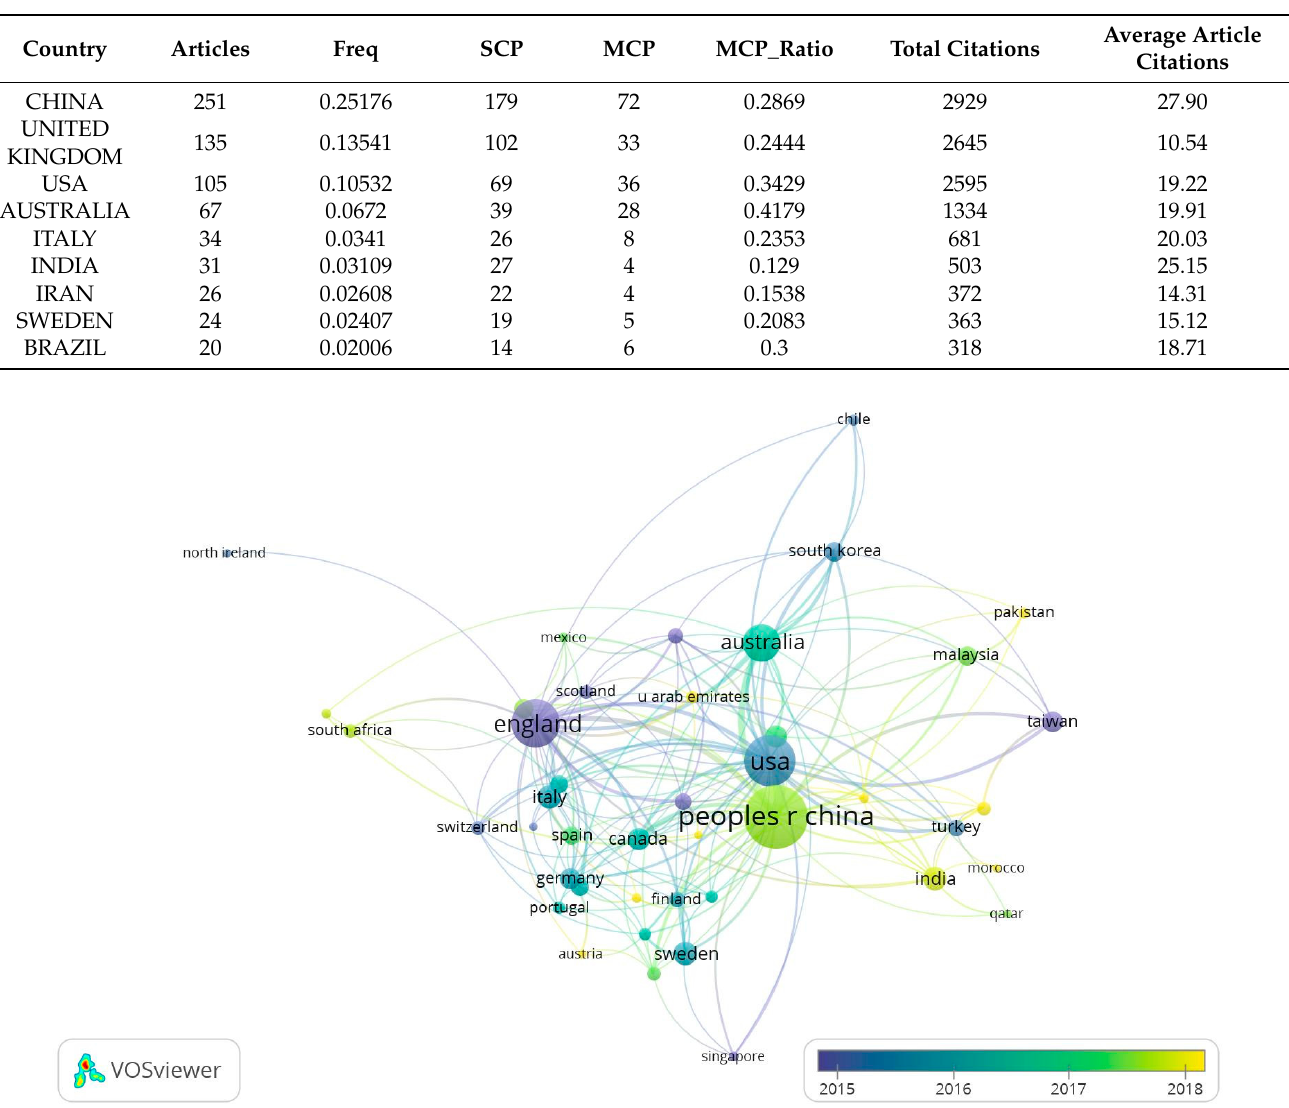
Table 2. Top 10 countries/region of the corresponding authors of CSCM research.